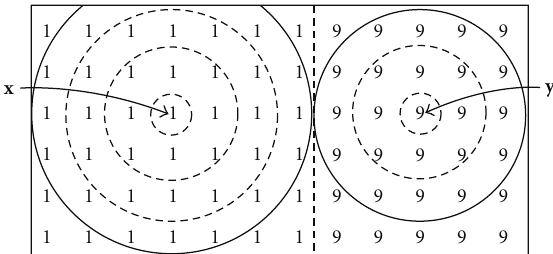
Figure 2: Noiseless image with boundary between two objects. Correctly scaled spheres S r ( x ) with r ( x ) = 3 and S r ( y ) with r ( y ) = 2 touch, but do not cross, the boundary. Numbers indicate pixel intensity.